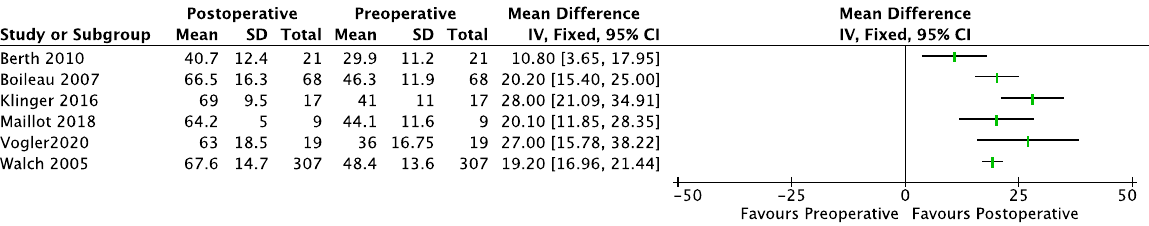
Figure 3. Forest plot of comparison: CMS (Constant-Murley Score), outcome in BT. SD: Standard Deviation.